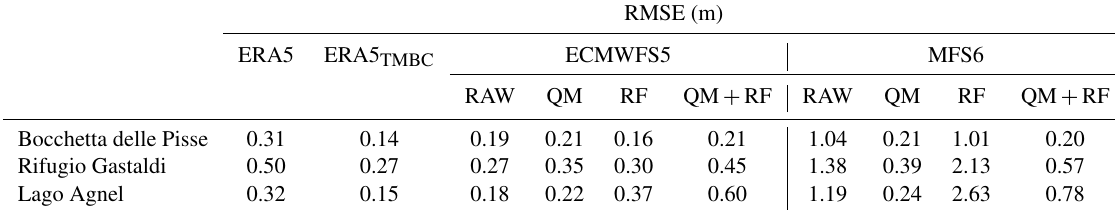
Table 4. RMSE between simulated and observed daily snow depth climatologies at the station of Bocchetta delle Pisse for the experiments listed in Table 3. Model simulations are obtained by forcing SNOWPACK with ERA5, ECMWFS5 and MFS6 meteorological variables. ECMWFS5 and MFS6-driven experiments (RAW, QM, RF and QM + RF) differ in the treatment of total precipitation (see Table